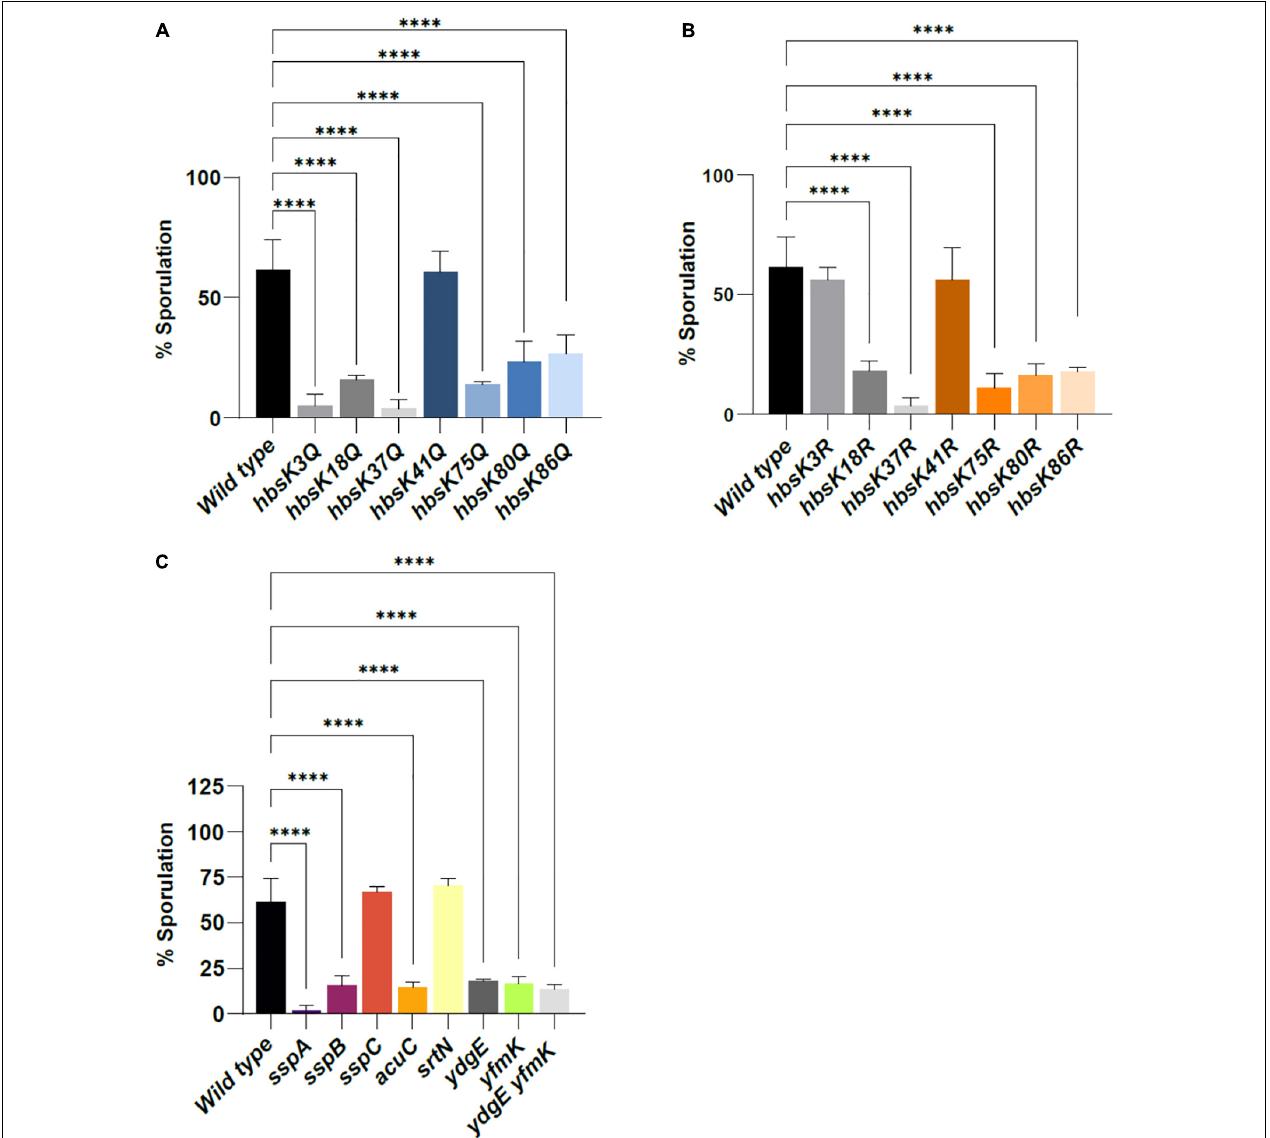
FIGURE 1 | The effects of acetylation on sporulation frequency. B. subtilis strains were grown in sporulation media for 24 h, and subsequently exposed to heat for 30 min to kill vegetative cells. The sporulation frequency was calculated as heat-resistant colony forming units (CFUs)/ml divided by total viable counts (CFU/ml), pre-heat treatment. Bar graphs represent the average percentages determined from at least three independent replicates with error bars representing standard deviations. Strains used were as follows: (A) wild-type (BD630), hbsK3Q (BD8577), hbsK18Q (BD8219), hbsK37Q (BD8119), hbsK41Q (BD8147), hbsK75Q (BD8398), hbsK80Q (BD8576), kbsK86Q (BD7493). (B) hbsK3R (BD8387), hbsK18R (BD8190), hbsK37R (BD8120), hbsK41R (BD8148), hbsK75R (BD8333), hbsK80R (BD7484), and hbsK86R (BD7506). (C) acuC (BD6861), srtN (BD7375), ydgE (BD7199), yfmK (BD7203), yfmK ydgE (VCB56), sspA (VCB4), sspB